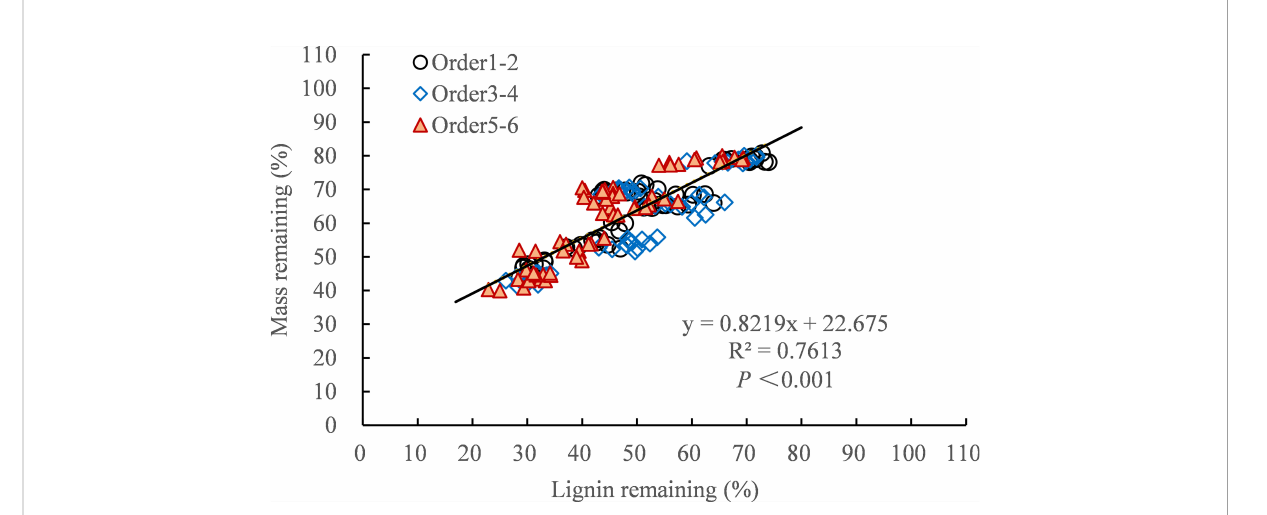
FIGURE 6 Relationship between residual mass and residual lignin after 30 months of